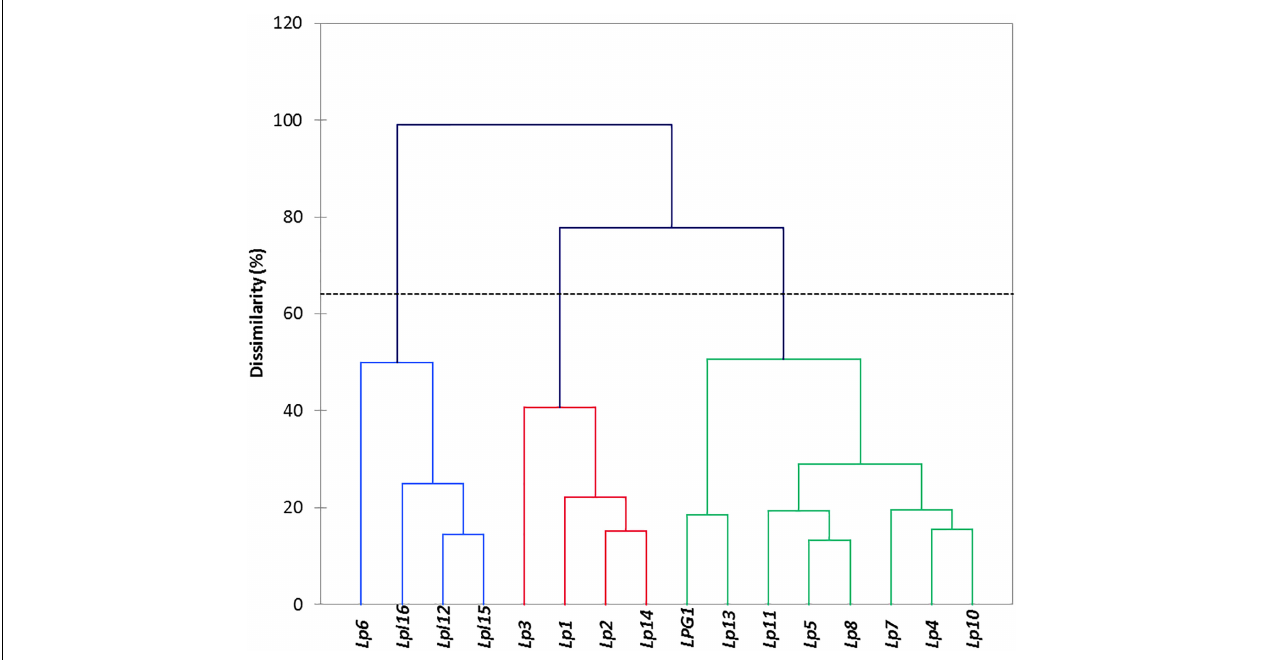
FIGURE 3 | Clustering obtained after multivariate analysis using the XLSTAT software. Cluster indicates the relation between genotypes, based on the results of the probiotics and technological